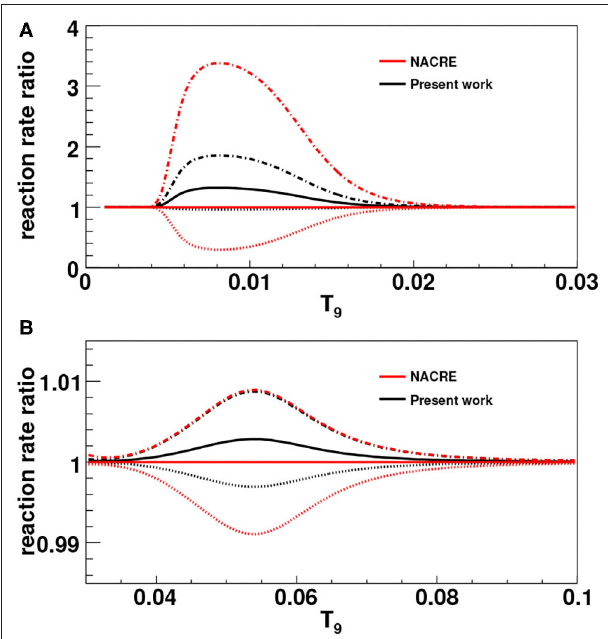
FIGURE 8 | Comparison of the reaction rate of the 18 O( p , α ) 15 N reaction with the NACRE one ( Angulo et al., 1999). In (A) , the contribution of the 20 keV resonance is shown; in (B) , the one of the 90 keV resonance (the upper limits for the NACRE and present-work rates overlap).